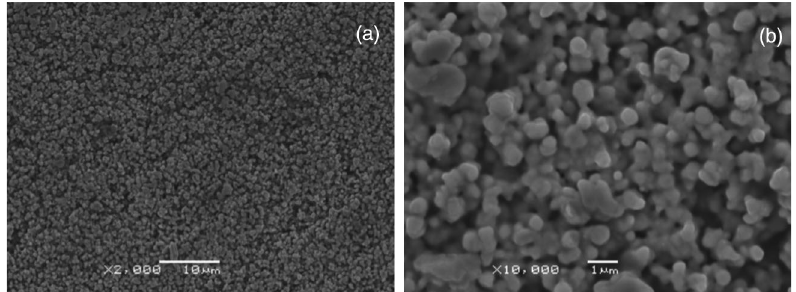
FIG. 3. SEM micrographs of a Pb film deposited on Nb, with energy density 0 : 12 J = cm 2 , a pulse duration of 5 ps, and a wavelength of 248 nm: (a) low magnification; (b) high magnification.